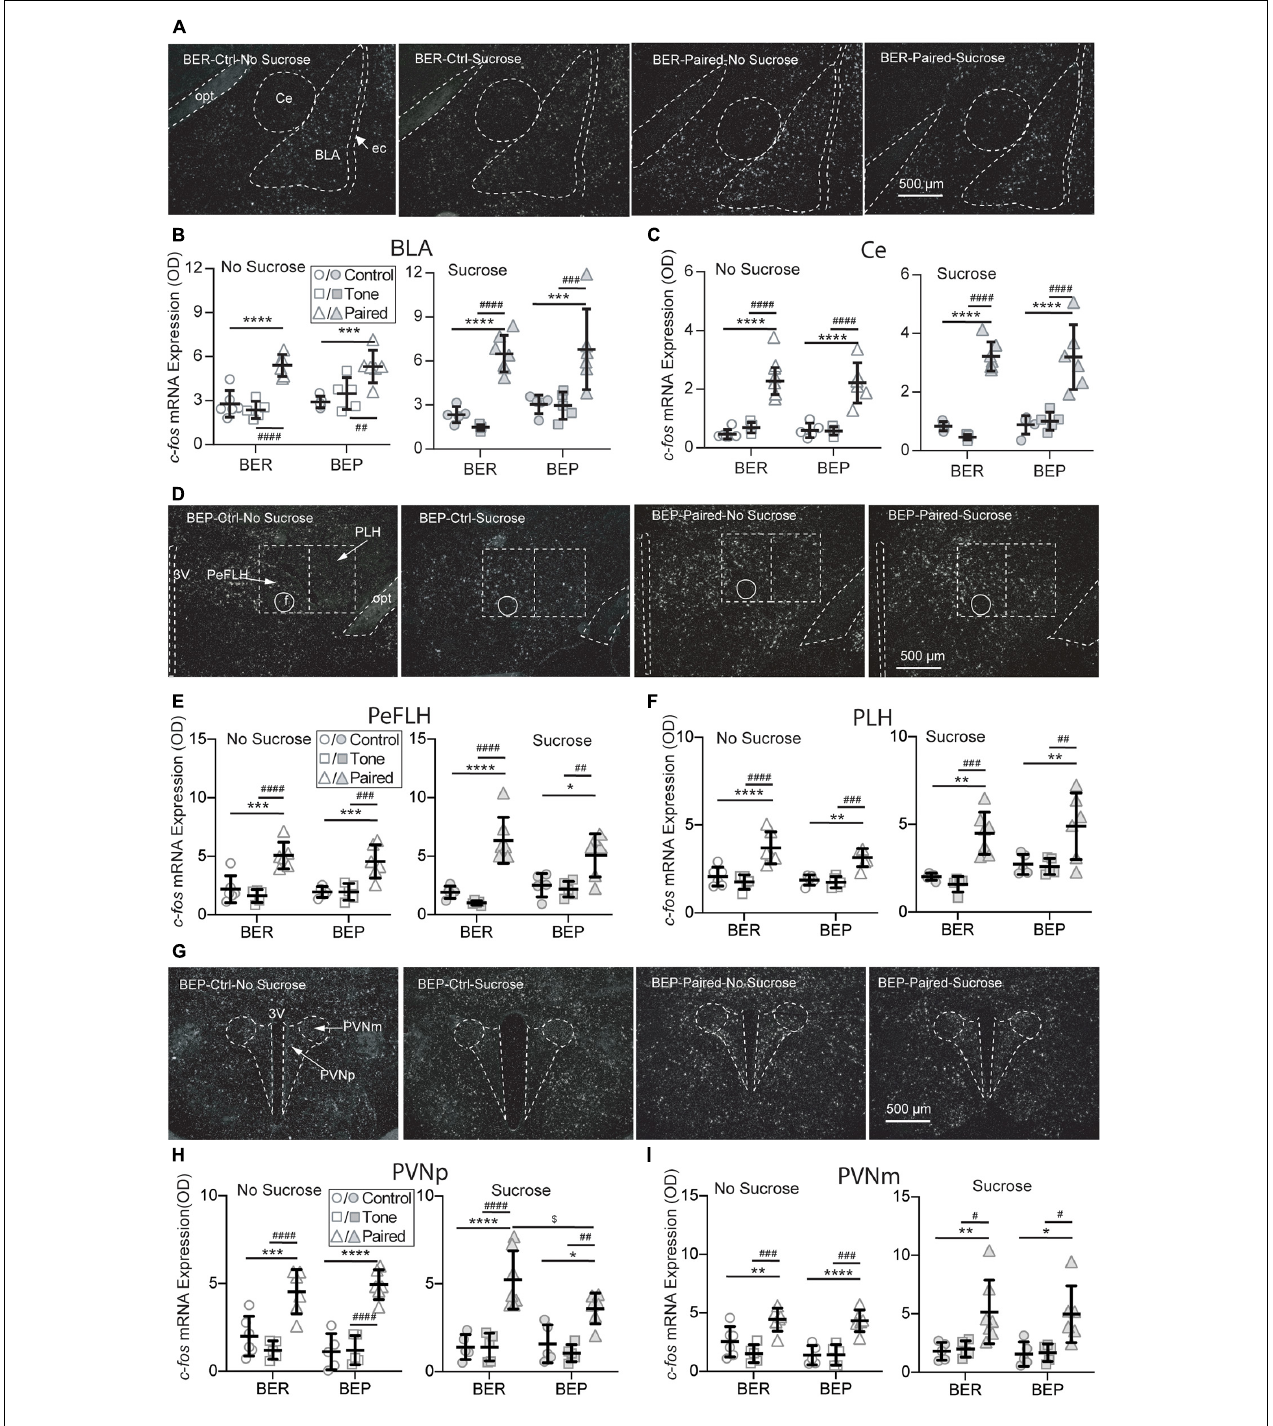
FIGURE 5 | Effects of fear conditioning on the c-fos mRNA expression in the amygdala, LHA, and PVN. Representative images of the c-fos mRNA in situ hybridization signals in the central amygdala (Ce), basal lateral amygdala (BLA), perifornical (PeFLH), and peduncular part (PLH) of the lateral hypothalamus, and parvocellular part (PVNp) and magnocellular part (PVNm) of the paraventricular hypothalamic nucleus marked with broken contours (A,D,G) . Relative c-fos mRNA expression of No Sucrose and Sucrose groups in the amygdala (B,C) , LHA (E,F) , and PVN (H,I) of BERs and BEPs. 3V, 3rd ventricle; ec, external capsule; f, fornix; opt, the optic tract; rf, rhinal fissure. *Significantly different ( p < 0.05) from the Control group within the same phenotype. ** p < 0.01, *** p < 0.001, **** p < 0.0001. # Significantly different ( p < 0.05) from the Tone group within the same phenotype. ## p < 0.01, ### p < 0.001, #### p < 0.0001. $ Significantly different ( p < 0.05) from the BER group with the same